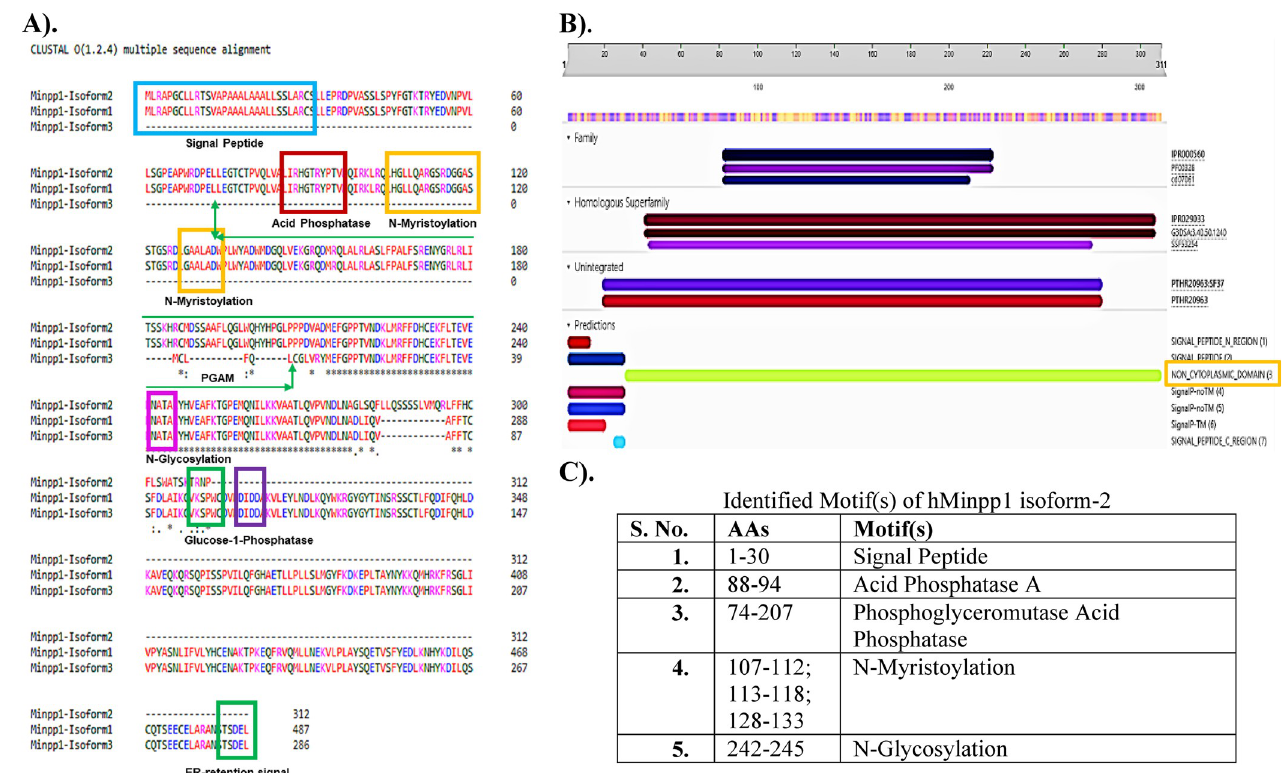
Fig 3. Minpp1 isoform-2 amino acid sequence analysis. A) . Multiple AAs sequence alignment of isoforms of hMinpp1. Three isoforms of hMinpp1 were identified as a translated outcome of the alternatively spliced hminpp1 gene. Homology modeling of the entire AAs sequences of three isoforms collected from NCBI sequence aligned to evaluate sequence similarity. AAs 213–278 were relatively conserved for all isoforms of hMinpp1. Isoform-1 (NP_004888.2) is a full- length protein. Isoform-2 (NP_001171588.1) comprises similar N-terminal sequences but lacks C-terminal sequences. Isoform-3 (NP_001171589.1) lacks the majority of N-terminal sequences but retains C-terminal sequences. The "NATA": N-Glycosylation site is conserved in all three isoforms, while glucose 1-phosphatase (DIDD) and ER retention (SDEL) motifs were absent in isoform-2, B). The InterPro protein viewer for the Minpp1-isoform-2 (NP_001171588.1). The underlying tool—InterProScan—annotates protein’s domain and motifs using predictive models provided by multiple databases [60], C). Summary of the prospective motifs in hMinpp1 isoform-2 based on its sequence alignment with hMinpp1